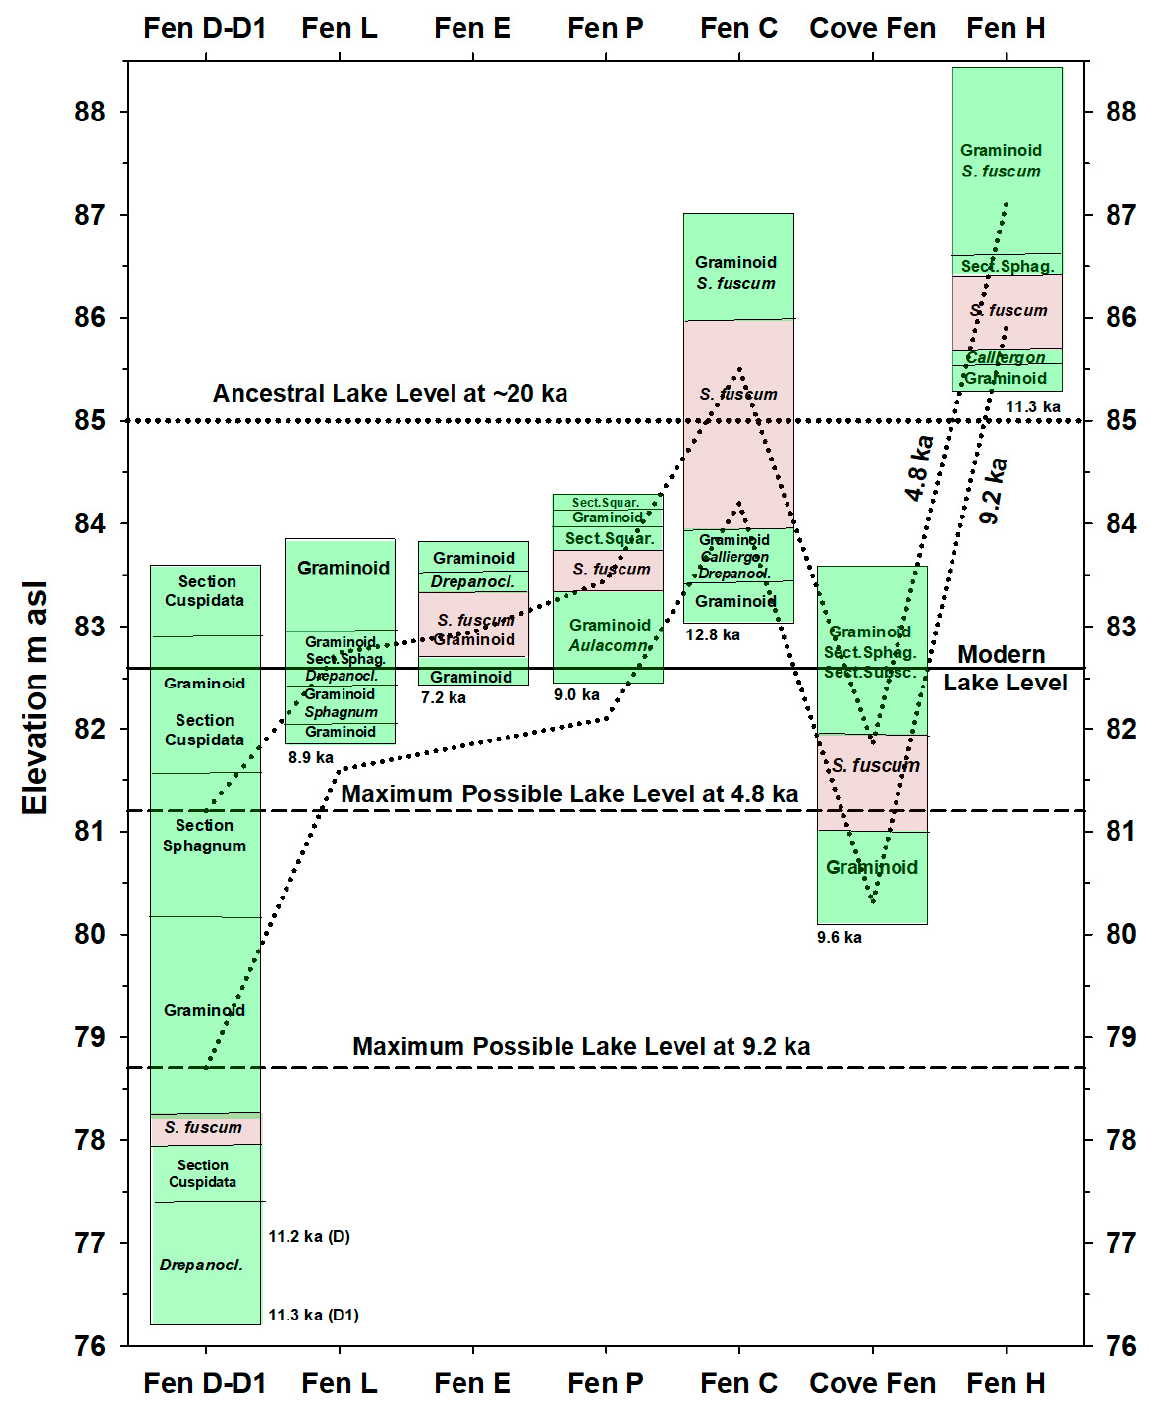
Figure 8. Summary graphic of Jigsaw Lake fen peats. Peat core sections from satellite fens are arranged clockwise around the lake from west to east. Green overlay shows wet fen conditions, brown overlay shows drier fen con- ditions. Maximum lake levels are estimated from the Fen D trajectory in Figure 9. Dotted lines show two important isochrons: 9.2 ka when lake level rise slows from the early rapid rise period, and 4.8 ka when the Cove Fen begins to flood and shift back to wetter